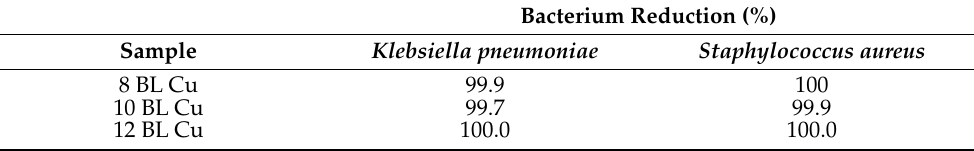
Table 6. Influence of treatments on the reduction of Klebsiella pneumoniae and Staphylococcus aureus bacteria after 24 h of incubation